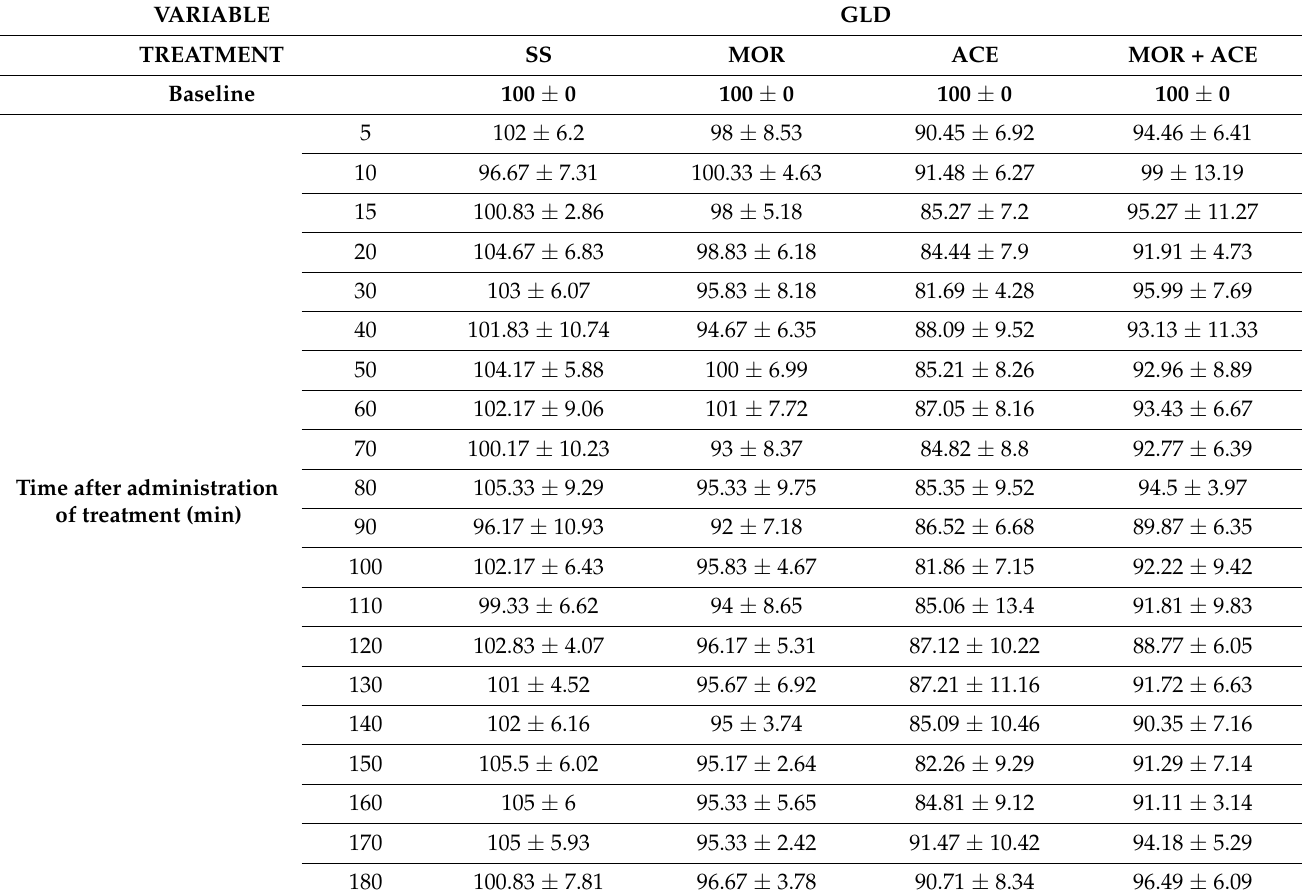
Table 6. Values at walk of tranquilization variable at − 10, 5, 10, 15, 20, and then every 10 min